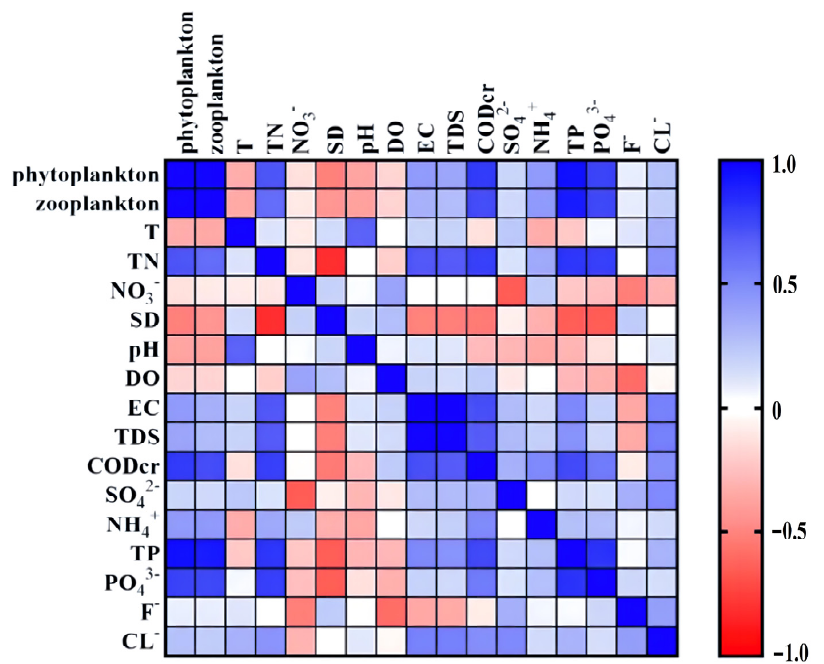
Figure 4. Pearson correlation analysis of the abundance of phytoplankton and zooplankton and water quality variables. The color represents the values of Pearson correlation coefficient.